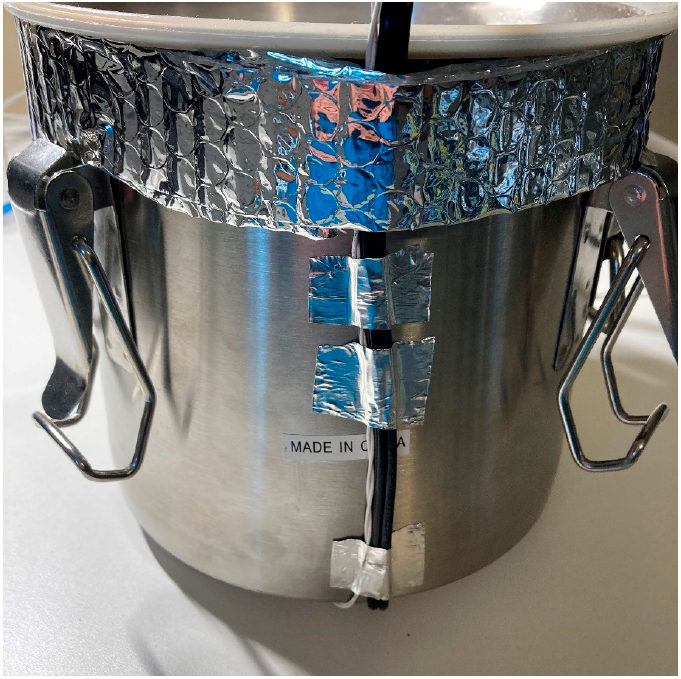
Figure 6. If installed, the heater power cable and sensor wires may be fed up the wall of the chamber for strain relief, but this is not required.